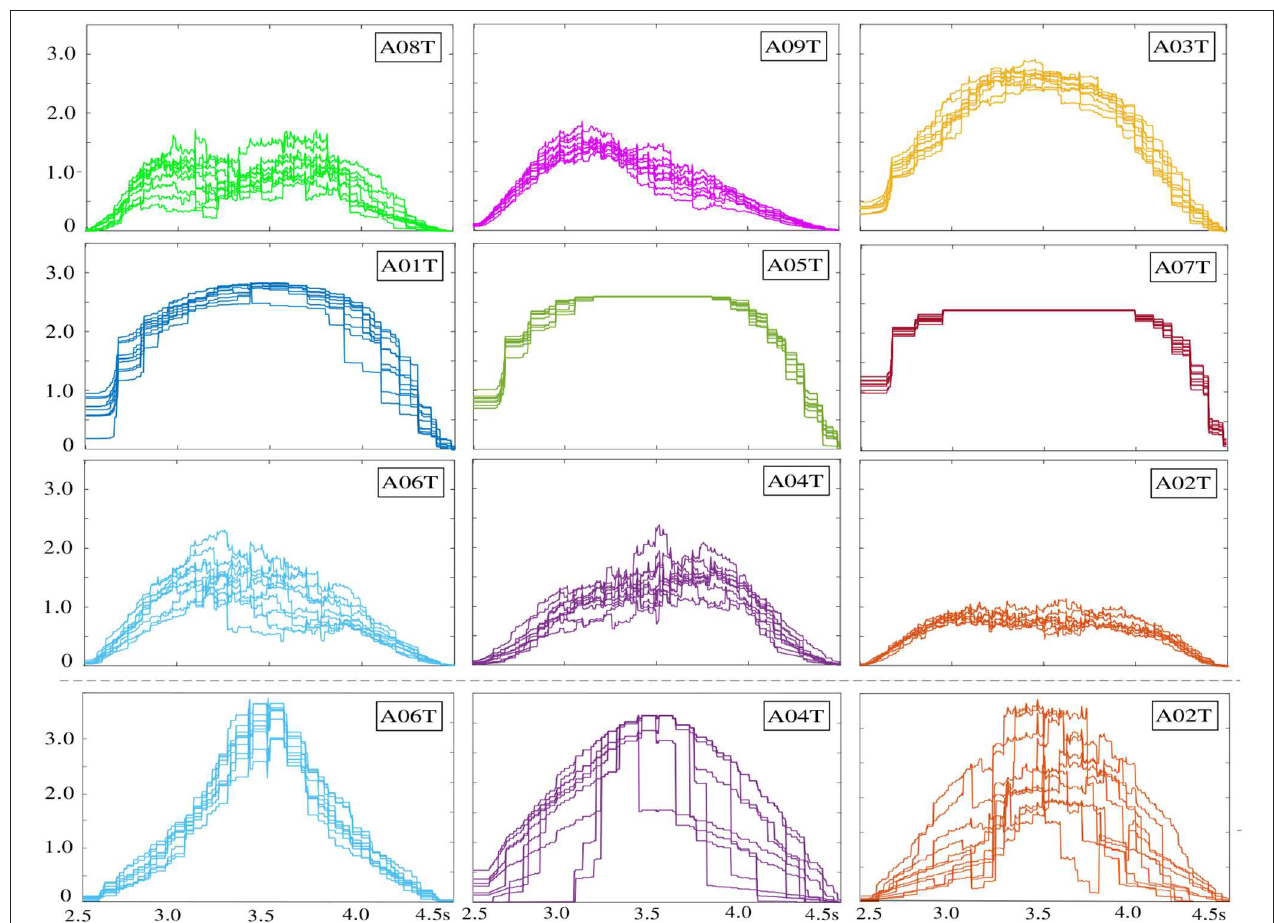
FIGURE 4 | Temporal dynamics from the absolute LASSO weights performed within the motor imagery period. Each time series is a cross-validated fold. The last row displays the subjects with lower accuracy after the optimization of the atom-based MIL representation stage.